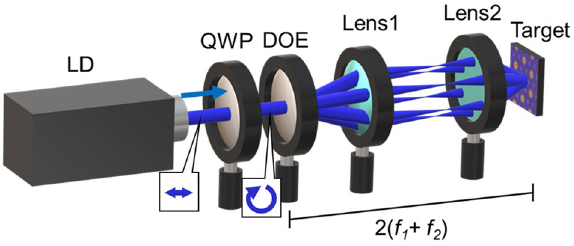
Figure 6. Experimental setup. LD CW laser diode, QWP quarter-wave plate, DOE diffractive optical element that diffracts 4- or 6-beams